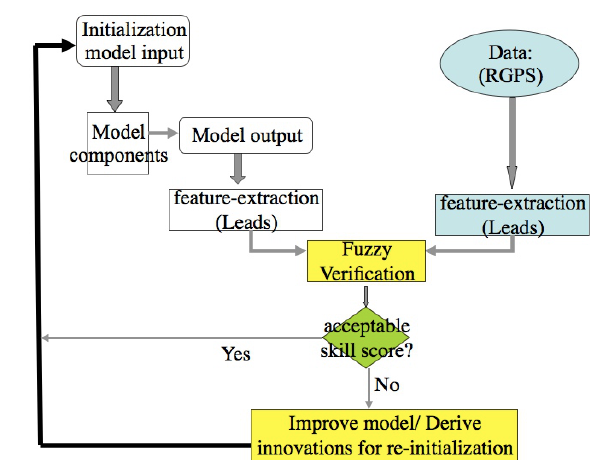
Fig. 1. Schematic of the validation and assimilation algorithm illus- trated for the general case and (in parentheses) lower dimensional features and the sea ice model and data tested. The implementa- tion and testing on lower dimensional features involve the assimila- tion of RGPS data processed to show regions of high deformation. The model state may be updated by changing material properties based on agreement of lower dimensional features and fuzzy met- rics scores. For example, if the data indicates the presence/absence of LKFs in a region, a jump in displacement is determined to ac- count for the observed RGPS deformation of the